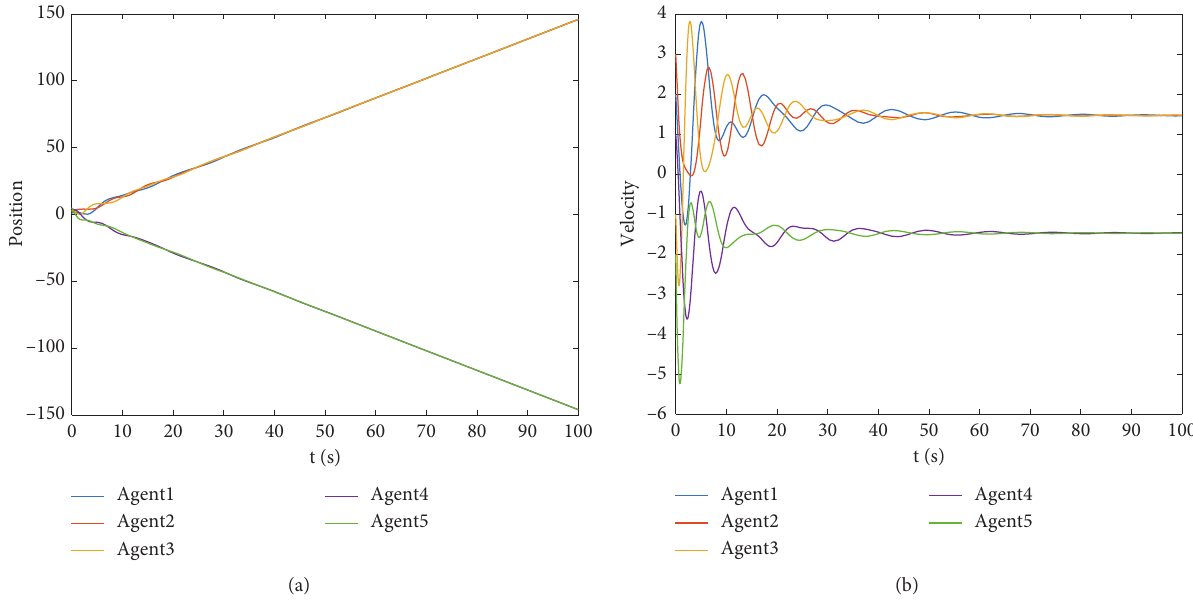
Figure 2: τ � 0 . 5 , τ � 0 . 4 , τ � 0 . 3 , τ � 0 . 2 , and τ � 0 . 1. (a) Position trajectories of all agents. (b) Velocity trajectories of all 1 2 3 4 5